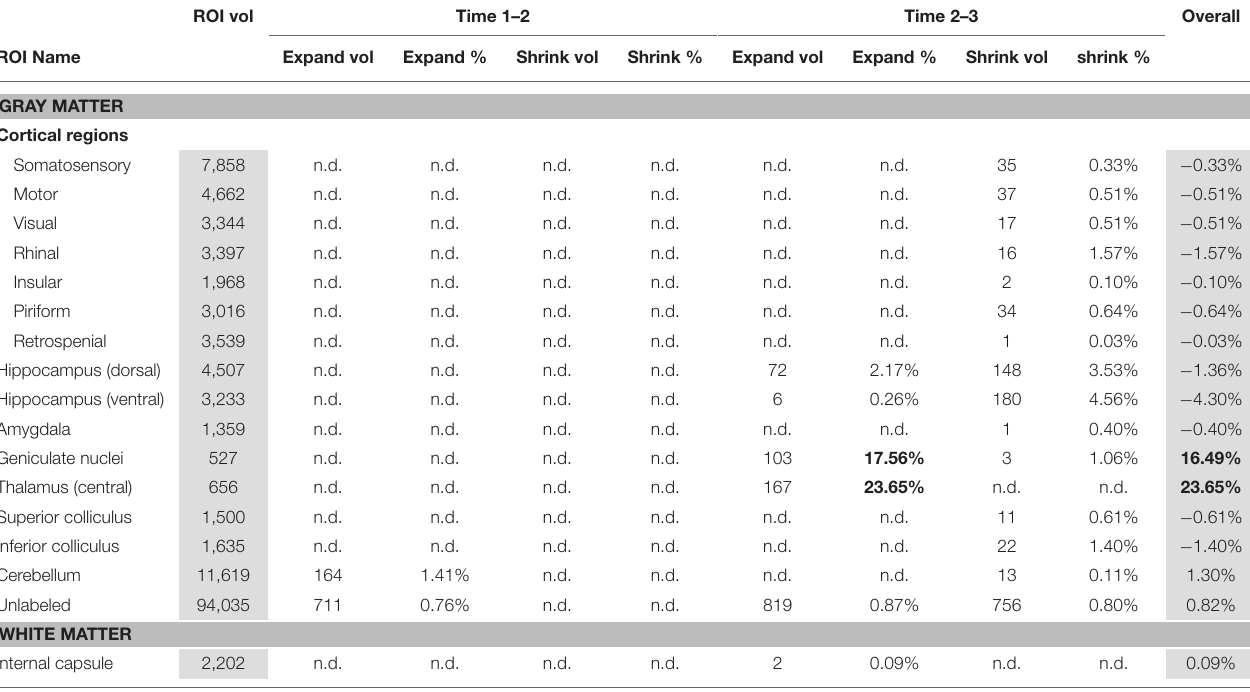
n.d, not detected. only regions showing 10% change are in bold and